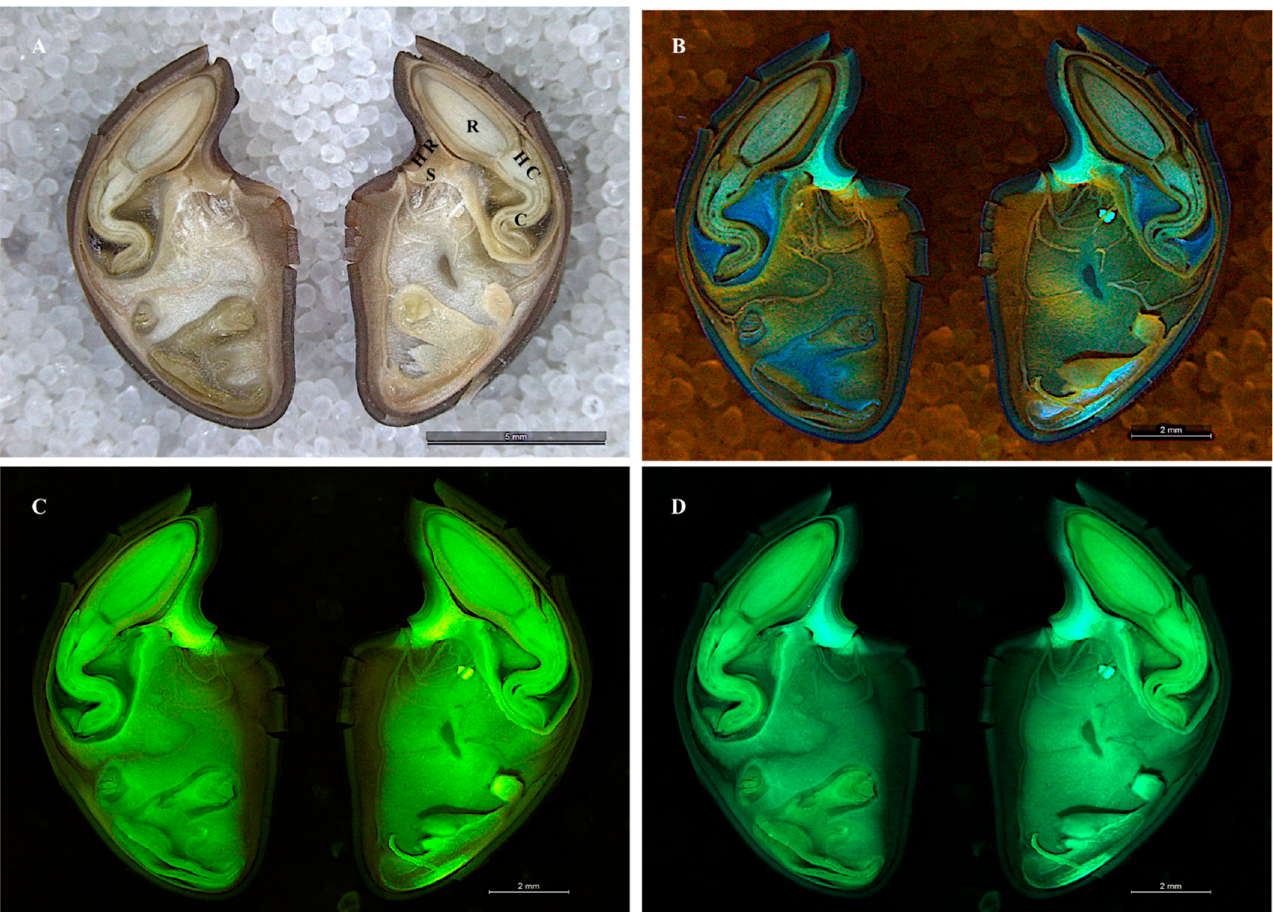
Figure 1. Stereofluorescence microscopy images of a longitudinal section of a hydrated positive Ipomoea carnea seed shown as a point of reference with the following tissues labeled: hilum and the hilum ridge labeled (HR), the sclereids (S), the hypocotyl (HC), the radicle (R), and the cotyledons (C). Images captured by the reflection of white light ( A ) scale bar—5 mm, violet light ( B ) scale bar—2 mm, red light ( C ) scale bar—2 mm, and GFP1 light ( D ) scale bar—2 mm.